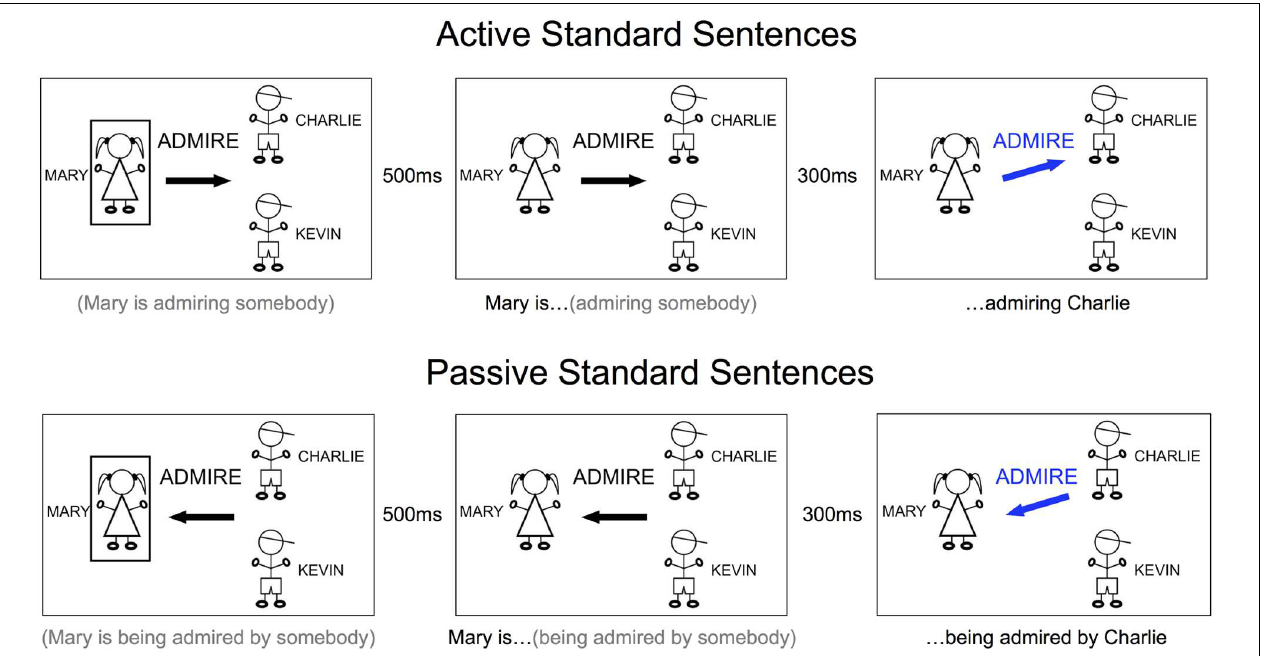
FIGURE 1 | Sample trials for standard sentences, active and passive. The words under each picture indicate what the subject was able to plan (in gray) and what the subject produced or began to produce (in black) during that stage of the cue. Only the image within the large black rectangles was part of the stimulus. LEFT: PREP stage, in which the subject prepared to begin producing the sentence with either active or passive construction. MIDDLE: GO stage, in which subject was cued to begin producing the incomplete sentence. RIGHT: FINISH stage, in which the completing information was presented. On standard trials, the subject’s final structure was consistent with